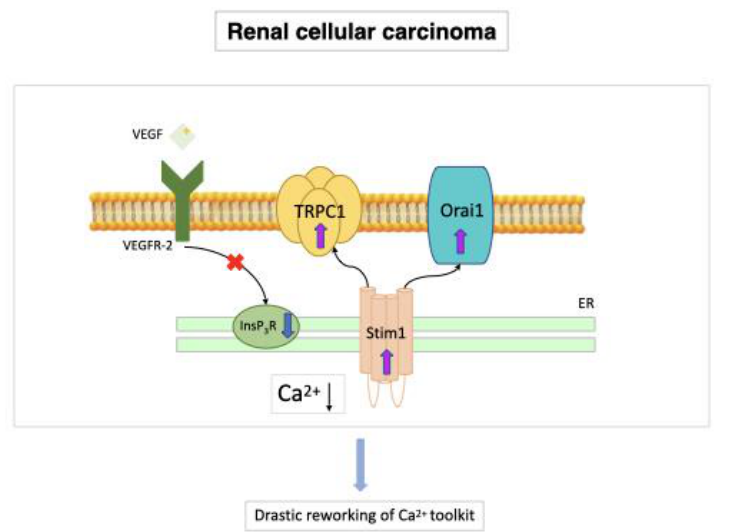
Figure 4. Stim1, Orai1, and TRPC1 (SOCE) in RCC-ECFCs. RCC-ECFCs show a significant